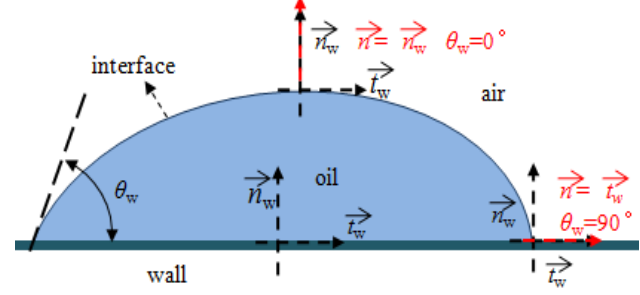
Figure 2. The diagram of contact angle.